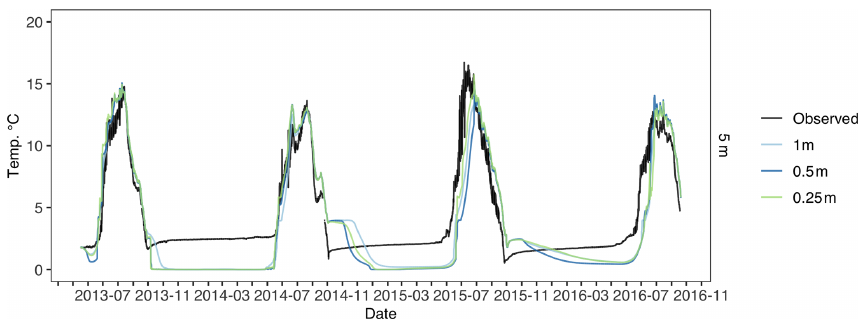
Figure D6. Toolik 5m water temperature across different water vertical resolution simulations. Observed water temperature is in black, 1m vertical resolution is in light blue, 0.5m vertical resolution is in blue, and 0.25m vertical resolution is in green.